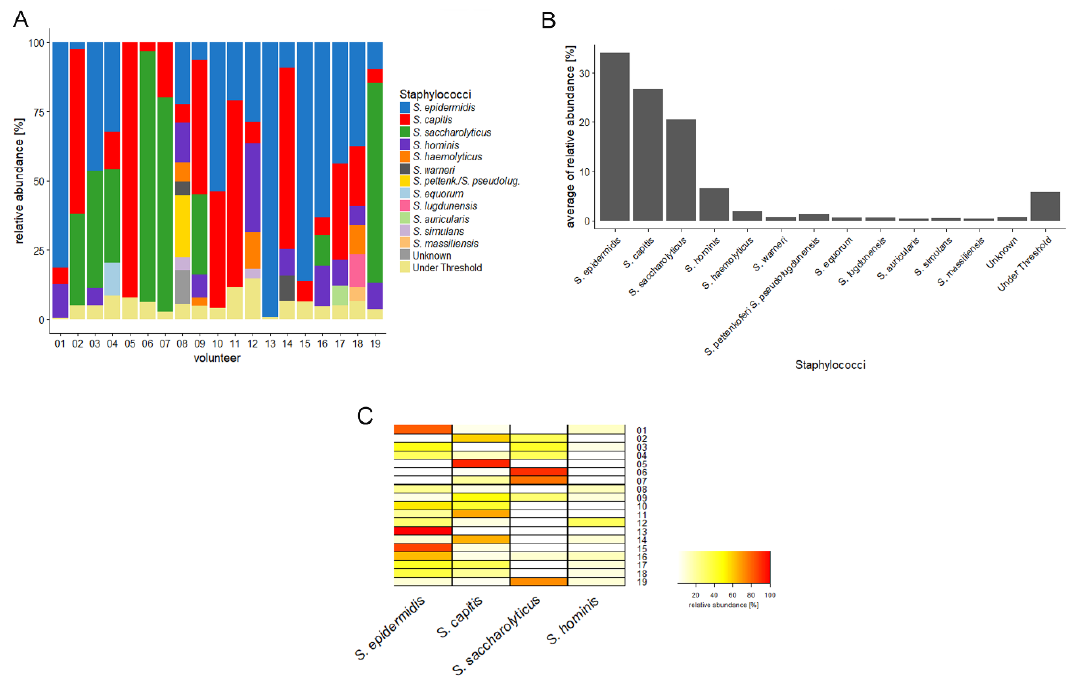
Figure 1. Diversity and abundance of staphylococcal species in back skin samples, based on amplicon next generation sequencing (NGS) data. ( A ) Relative abundance of staphylococcal species for each volunteer ( n = 19). Twelve staphylococcal species were identified in the cohort using the tuf amplicon- NGS approach. The four most abundant species in the cohort were Staphylococcus epidermidis (in blue), Staphylococcus capitis (in red), Staphylococcus saccharolyticus (in green) and Staphylococcus hominis (in purple). ( B ) The average relative abundance of the identified 12 staphylococcal species is shown; S. epidermidis was detected with an average abundance of 34.0%, S. capitis with 26.6%, S. saccharolyticus with 20.5%, and S. hominis with 6.5%. ( C ) The relative abundance of the four most prevalent